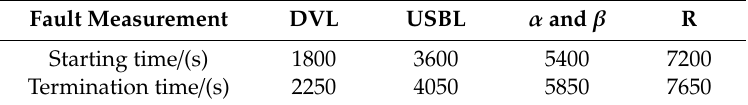
Table 2. The starting and termination time of measurement fault.